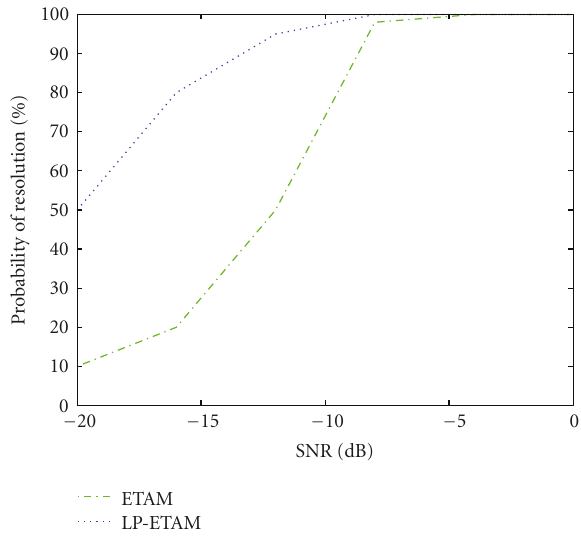
Figure 6: The probability of resolution for ETAM and